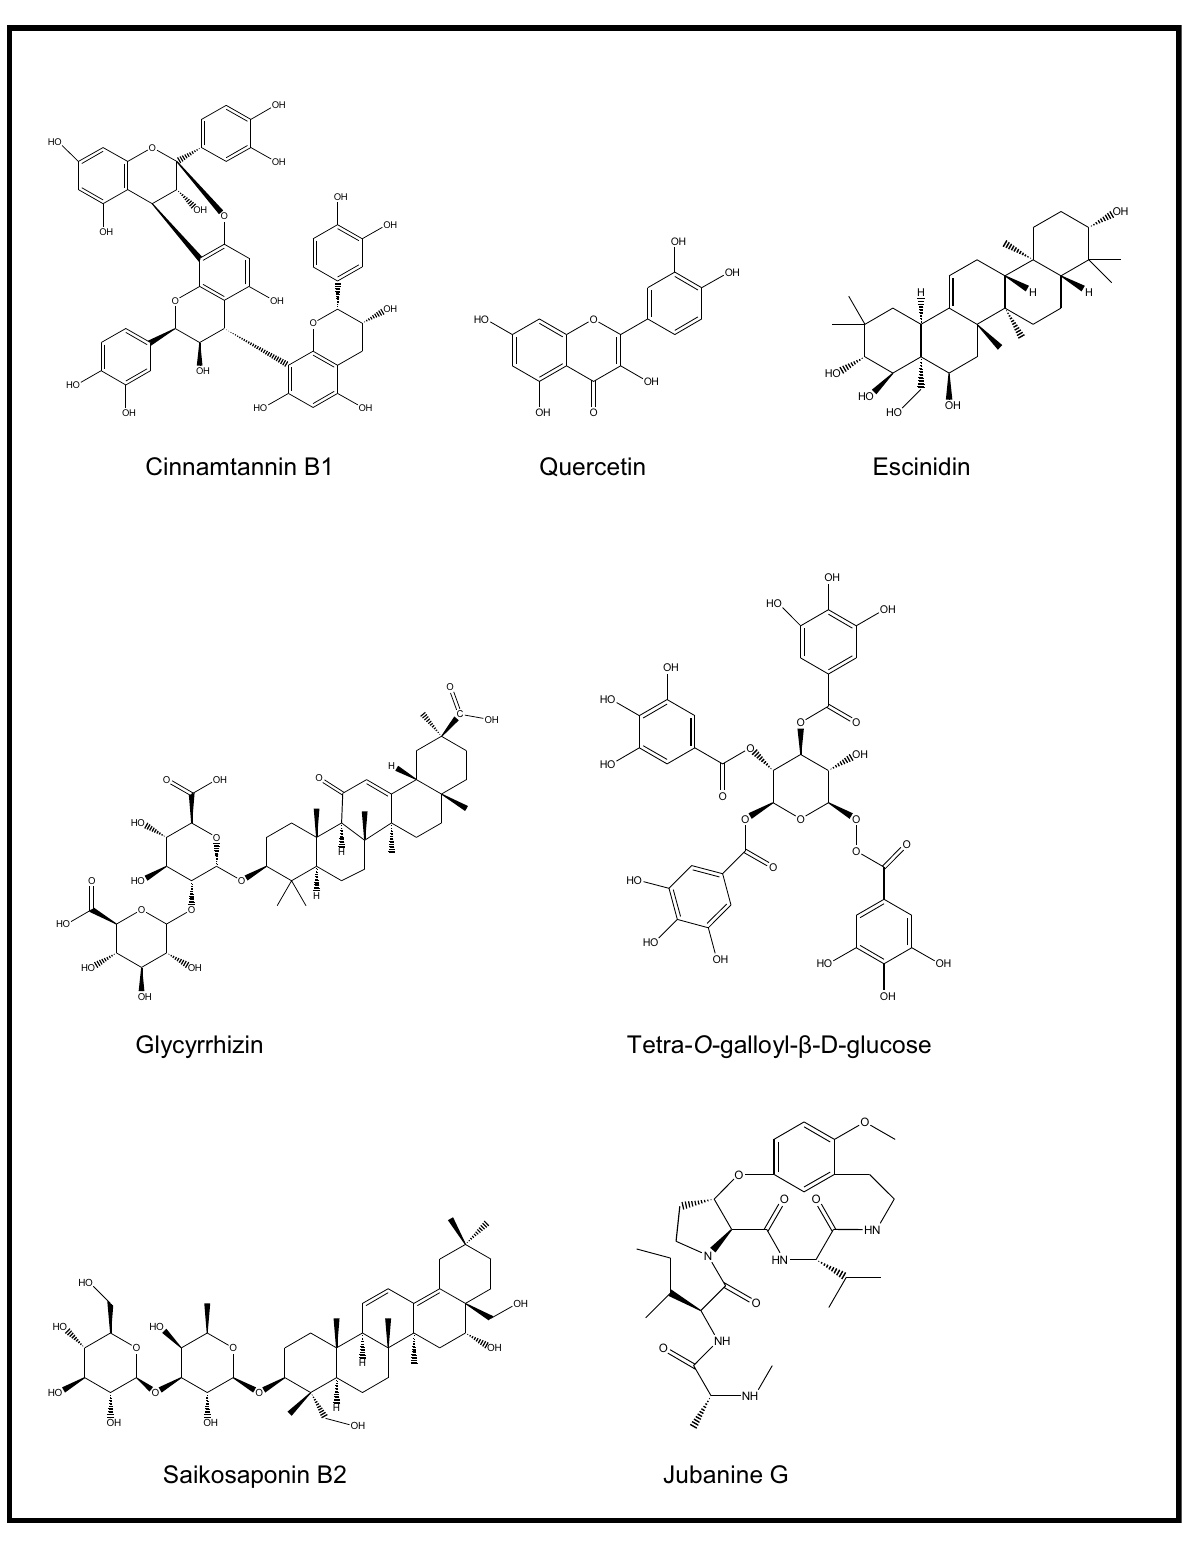
Fig. 1 Chemical structures of some promising natural